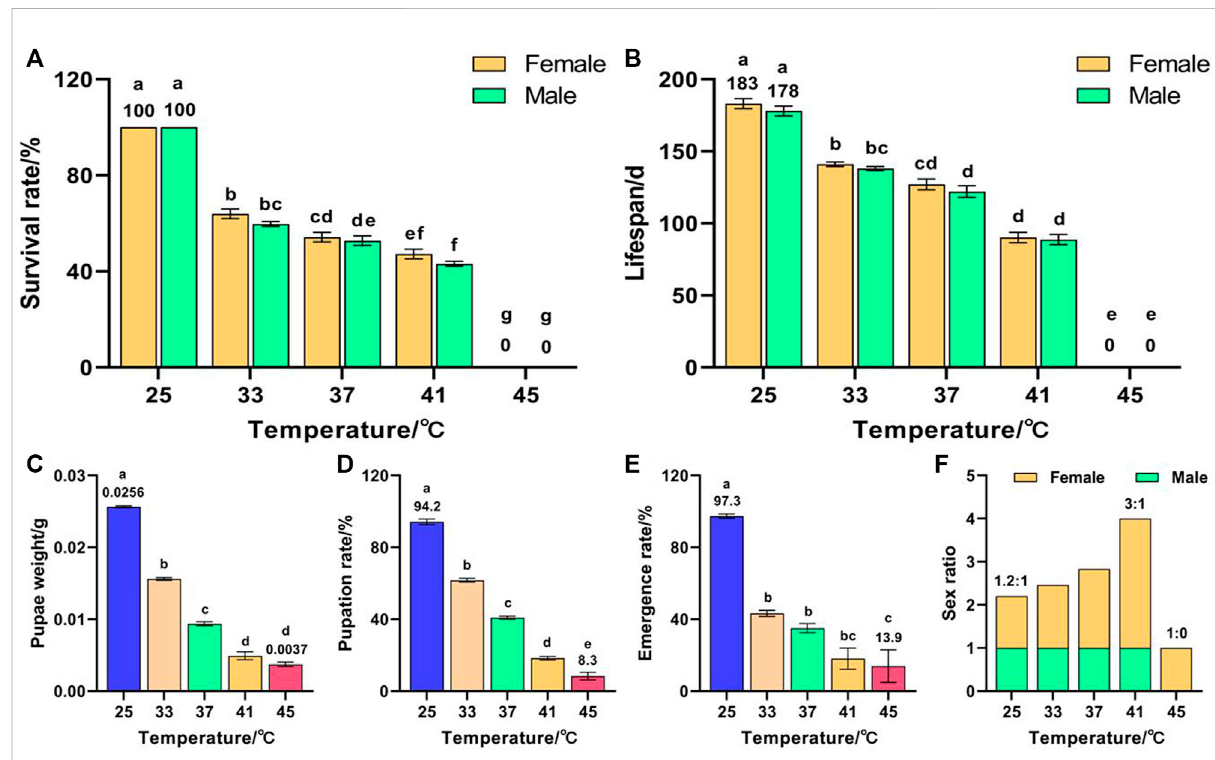
FIGURE 3 Effectsofshort-termhightemperatureonsurvivalandlifespanof Z.cucurbitae (F 3 ). (A) Survivalrate. (B) Lifespan. (C) Pupaeweight. (D) Pupation rate. (E) Emergence rate. (F) Sex ratio. The columns in the fi gure represent the mean ± standard error, and thelettersabove them indicate signi fi cant differences ( p ≤